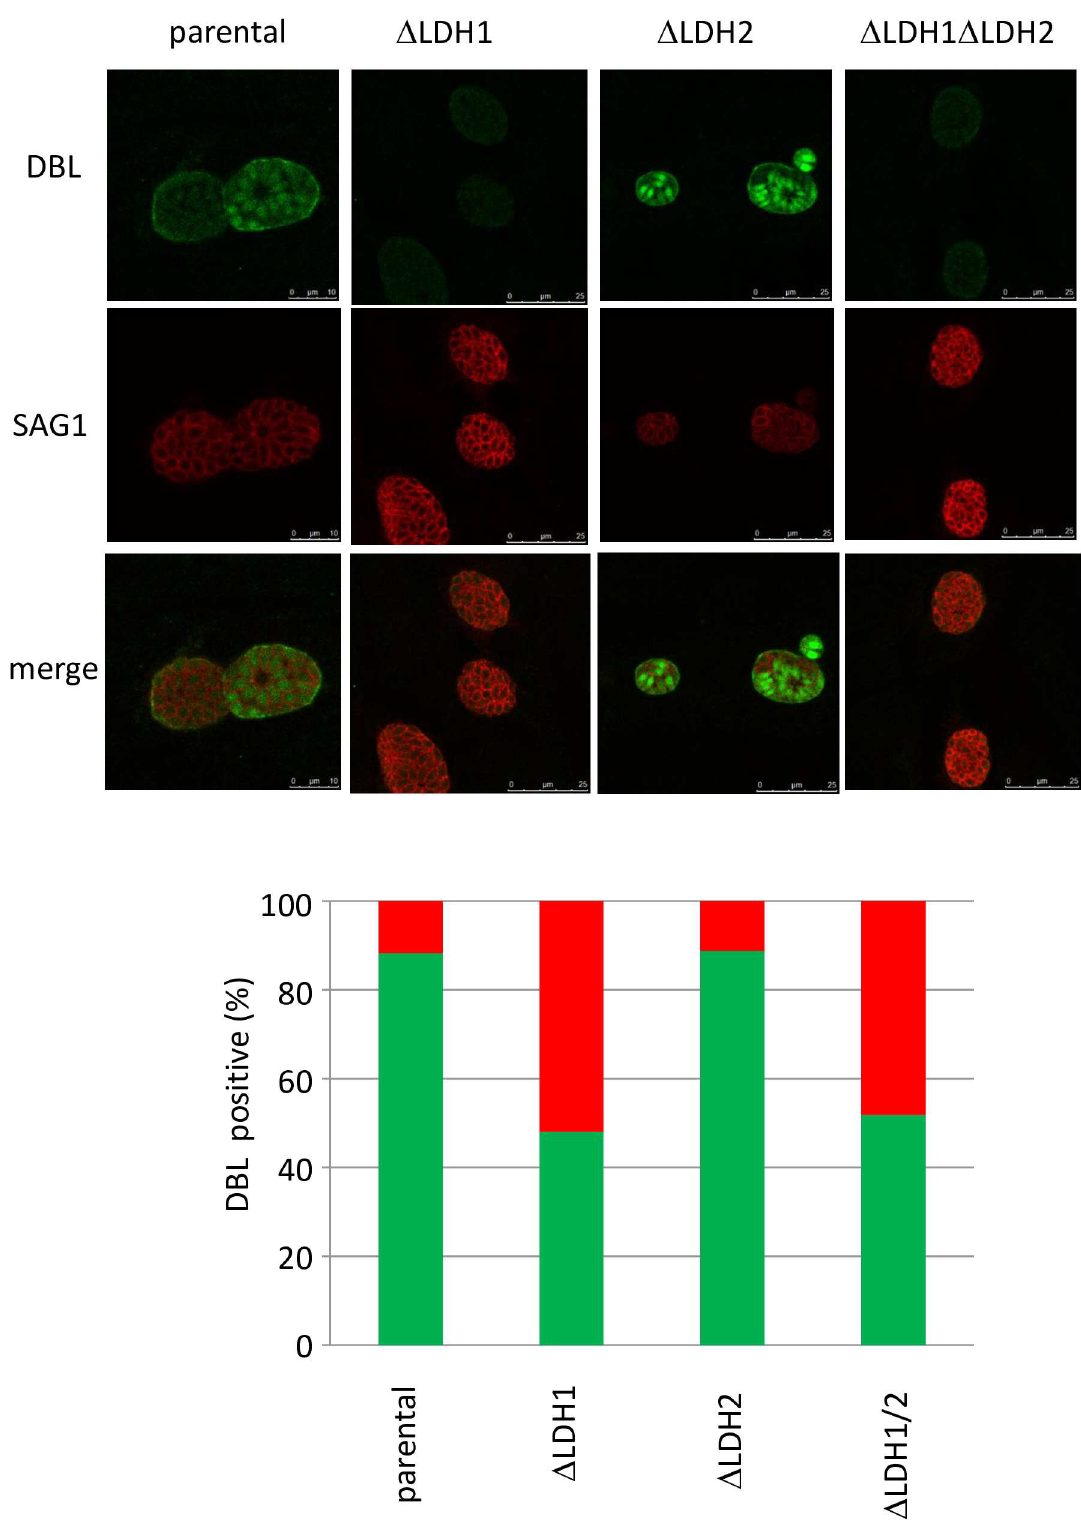
Fig 3. Analysis of stage conversion in parental and LDH knockout strains. Dolichosbiflorus lectin (DBL) (green)was used for cyst wall staining and anti-SAG1 (red) antibody was used for tachyzoite marker (upper panel). Percentage of DBL positive parasites of each 100 PV from two independentassays was calculated(lower